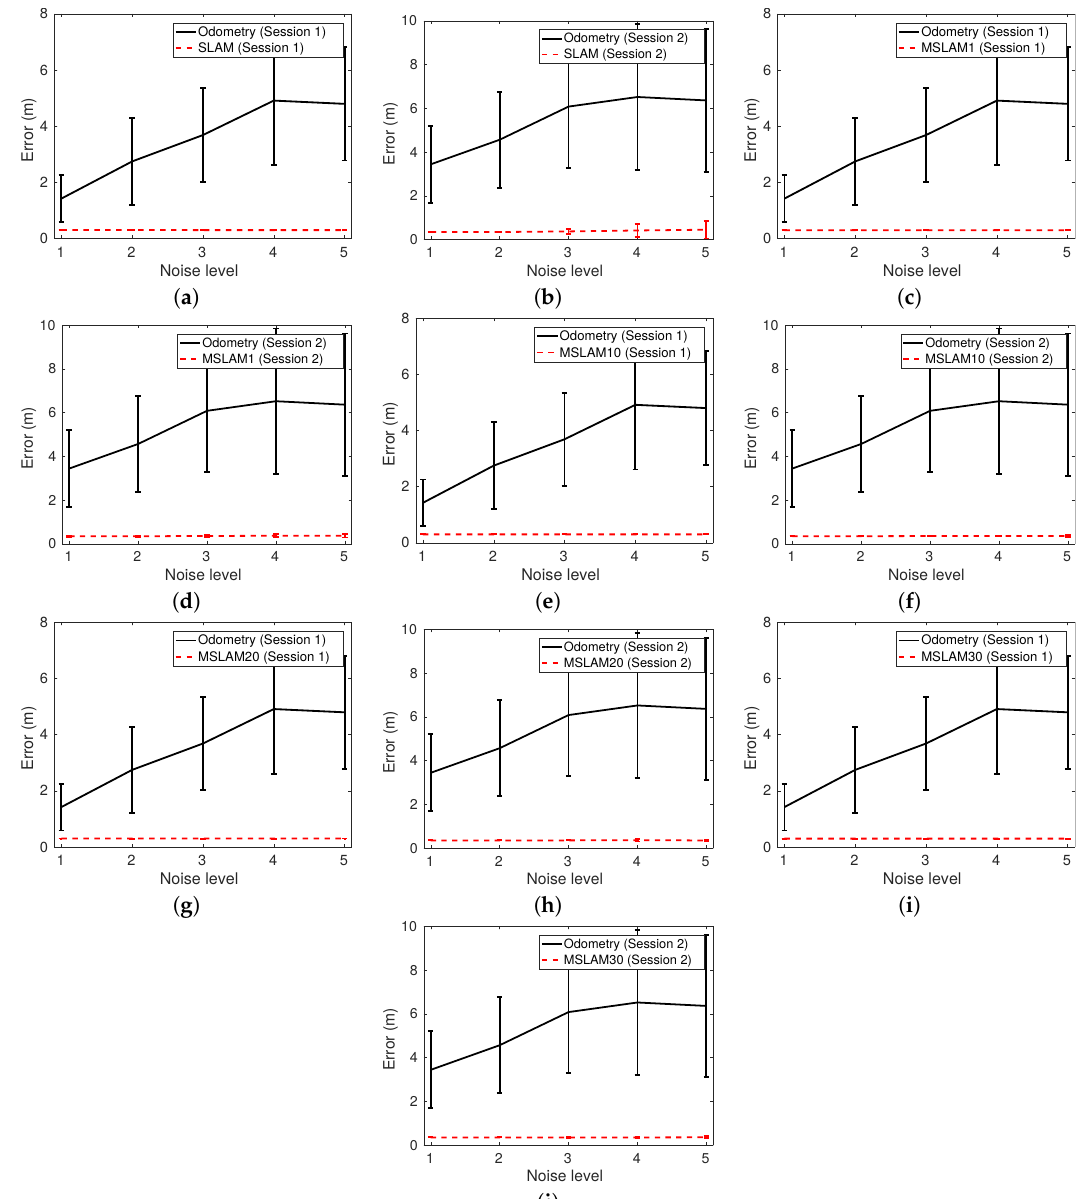
Figure 20. Mean and standard deviations of the errors in distance using synthetically corrupted odometry: ( a ) SLAM session 1 and odometry, ( b ) SLAM session 2 and odometry, ( c ) MSLAM1 session 1 and odometry, ( d ) MSLAM1 session 2 and odometry, ( e ) MSLAM10 session 1 and odometry, ( f ) MSLAM10 session 2 and odometry, ( g ) MSLAM20 session 1 and odometry, ( h ) MSLAM20 session 2 and odometry, ( i ) MSLAM30 session 1 and odometry, and ( j ) MSLAM30 session 2 and